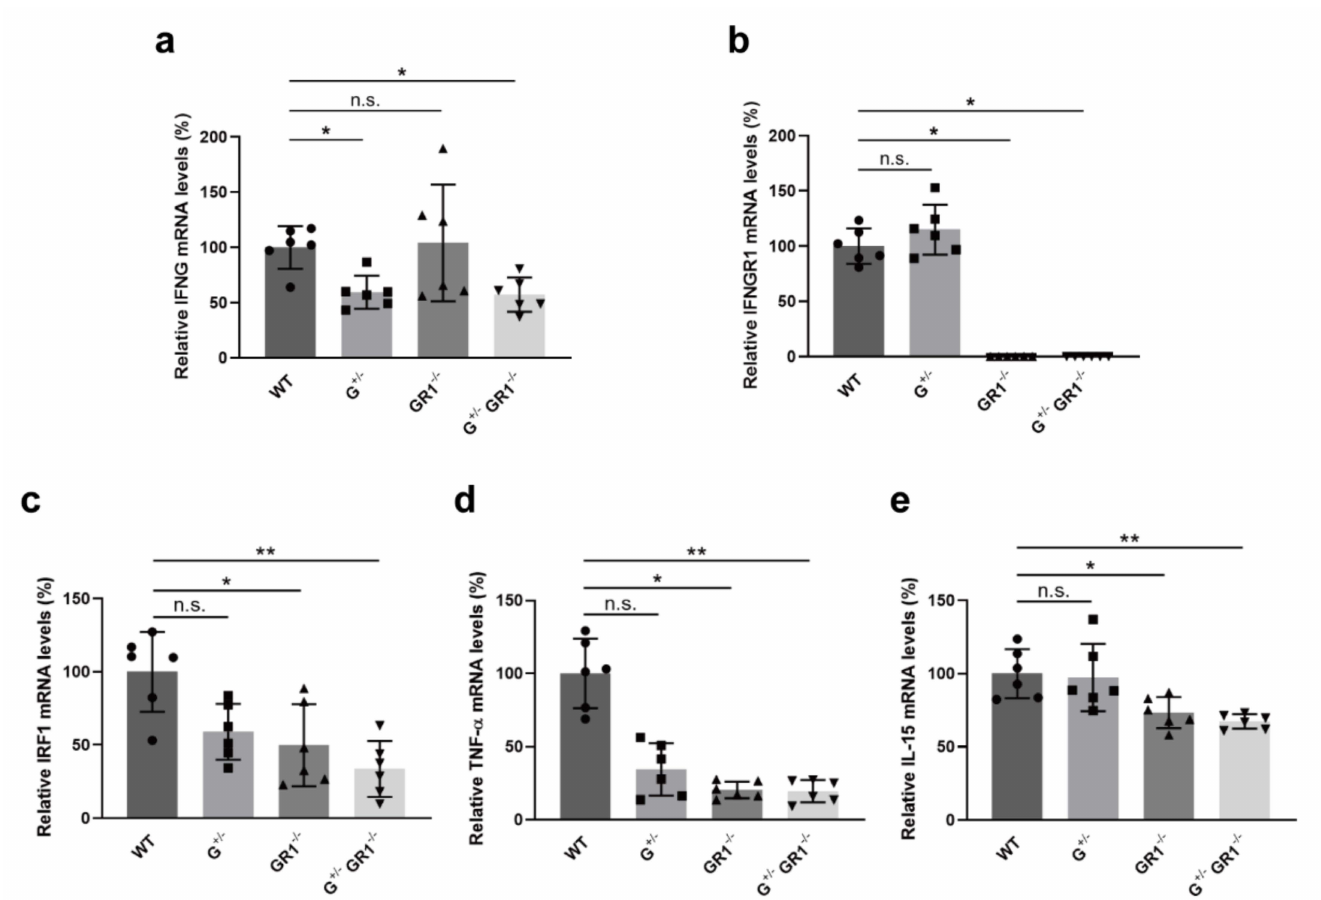
Figure 2. Downregulation of IFN- γ -responsive genes in IFNG - and IFNGR1 -knockout Vero cell lines. ( a ) Relative IFNG expression levels in G +/ − , GR1 − / − , and G +/ − GR1 − / − cell lines. IFNG mRNA levels in knockout cell lines were normalized to those of wild-type cells. Heterozygous knockout of IFNG in Vero cells reduced IFNG expression level by ~50% in G +/ − and G +/ − GR1 − / − cell lines. Results are shown as means ± SD of six independent replicates (applies to all gene-expression data, * p < 0.05; ** p < 0.01; n.s., not significant). ( b ) Relative IFNGR1 expression levels in G +/ − , GR1 − / − , and G +/ − GR1 − / − cell lines. The IFNGR1 gene was completely silenced in GR1 − / − and G +/ − GR1 − / − cell lines. ( c – e ) Relative expression levels of IRF-1 ( c ), TNF- α ( d ), and IL-15 ( e ) in G +/ − , GR1 − / − , and G +/ − GR1 − / − cell lines. Ablation of IFNG and IFNGR1 genes downregulated the transcription of genes related to the IFN- γ